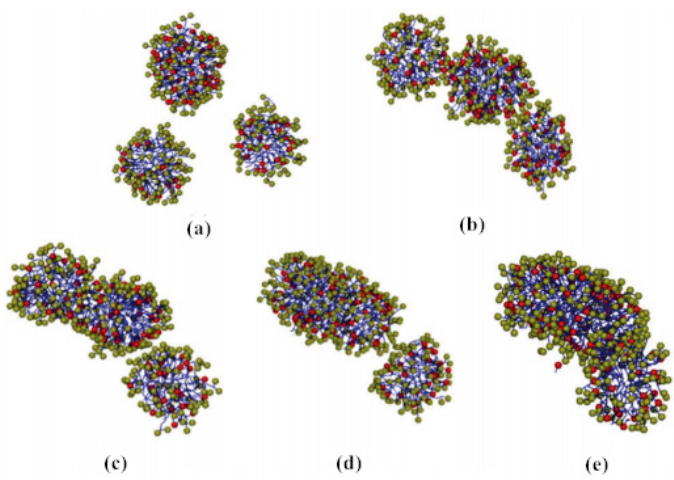
Figure 5. Transition process from globular micelle to wormlike micelle: ( a ) dispersed spherical micelles; ( b ) spherical micelles approach each others; ( c ) spherical micelles begin to merge; ( d ) two spherical micelles merge first; ( e ) three spherical micelles combine to form wormlike micelles [40].